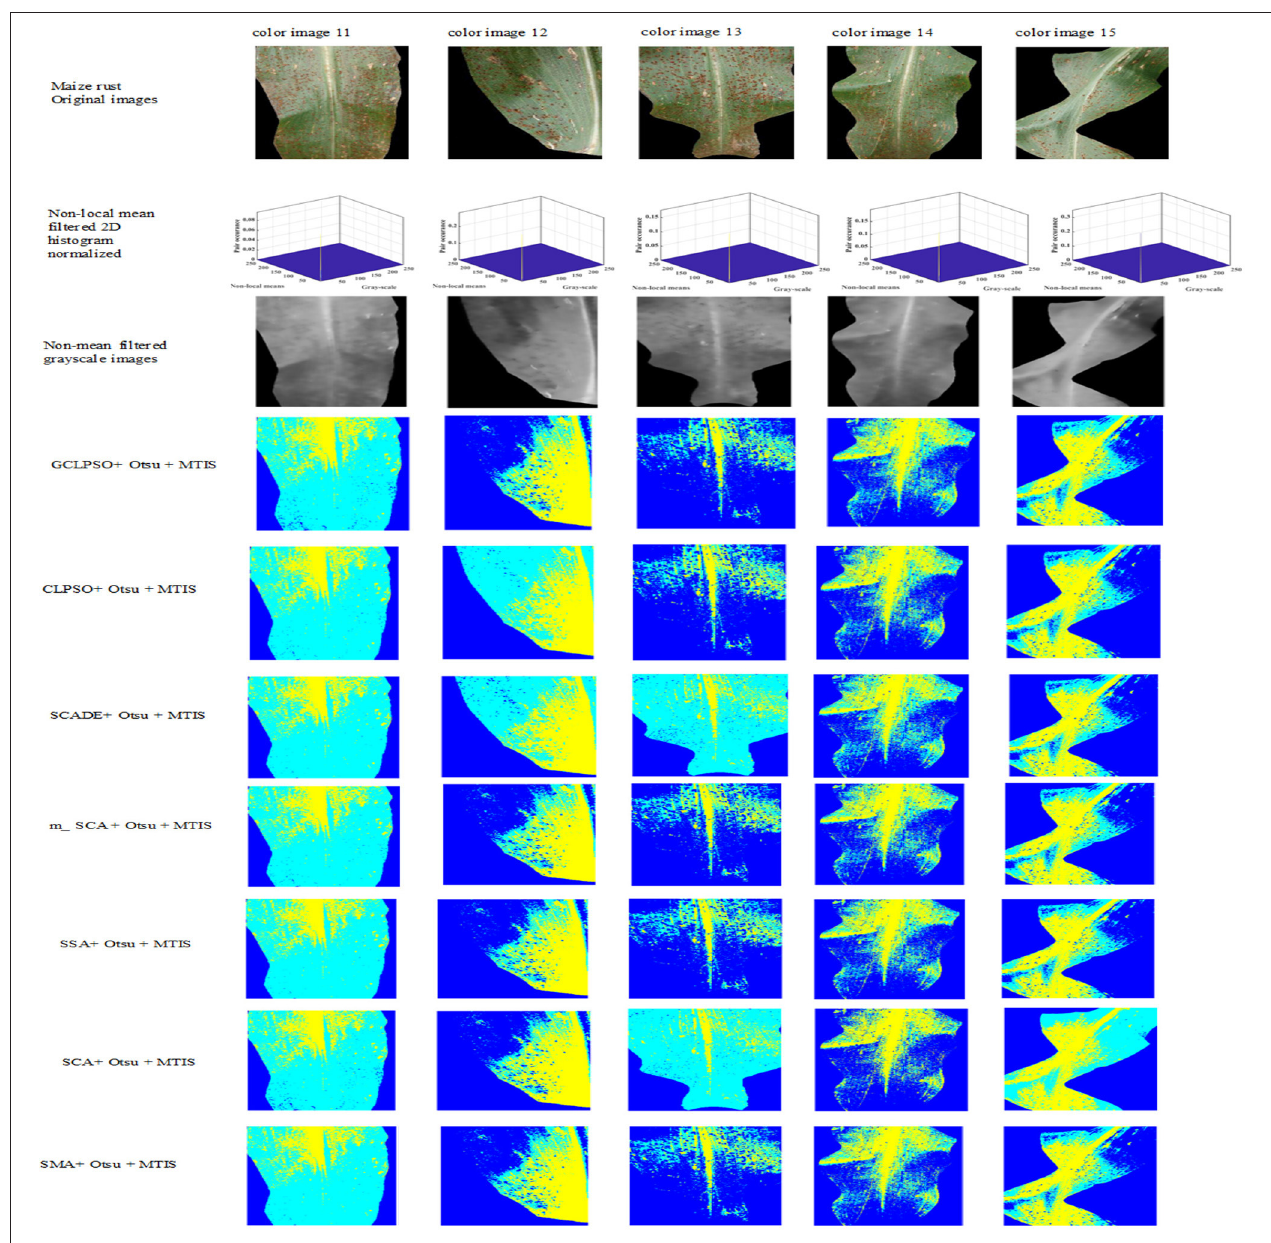
FIGURE 7 | Original images, non-local mean filtered 2D histogram, non-local mean filtered grayscale image results, and two-threshold color image segmentation results of all the algorithms of maize rust disease color images 11–15.